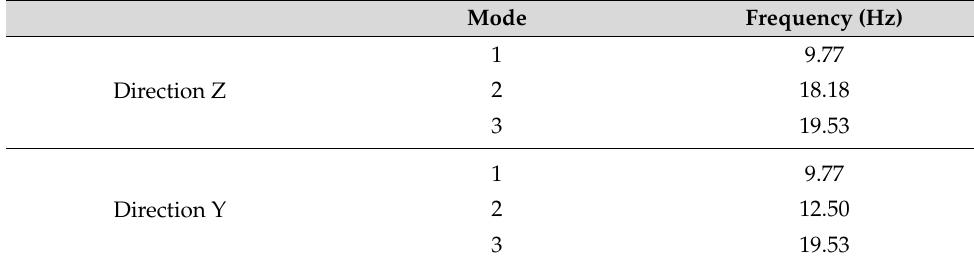
Figure 10. Frequencies most detected processing the measurements in Z- ( a ) and Y- ( b ) directions in all dynamic tests. Within round brackets: (frequency identified, number of appearances). Table 3. Identified experimental frequencies in Z- and Y-directions.